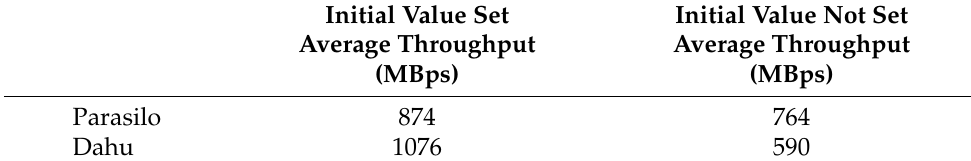
Table 8. Backpressure Initial Value